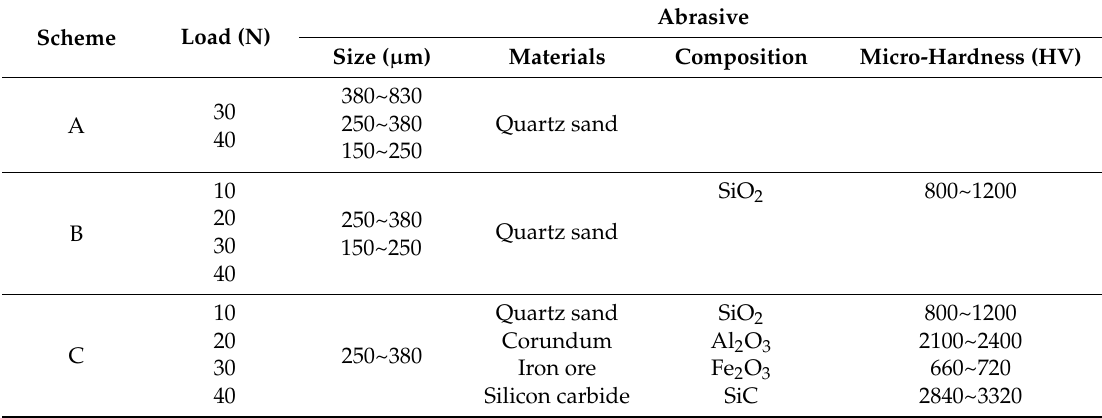
Table 1. Test scheme.